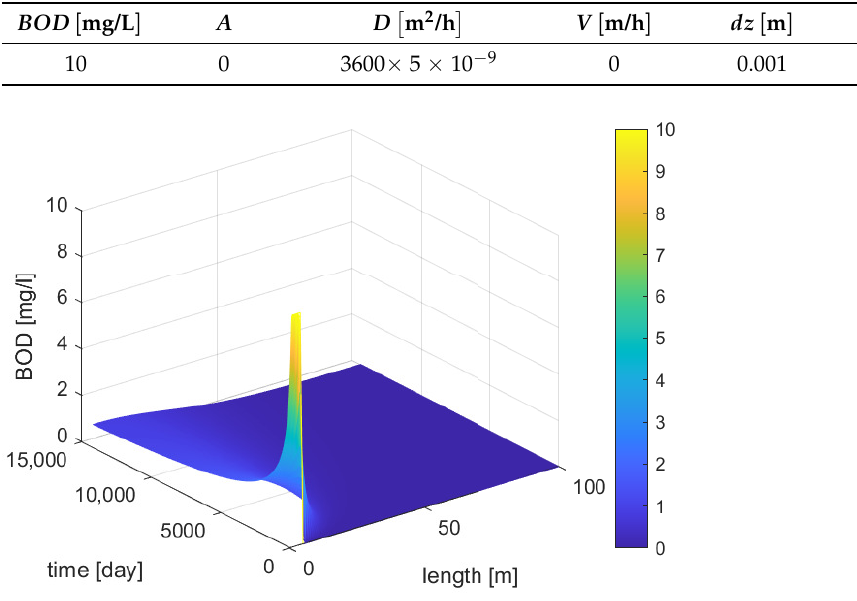
Table 1. Initial values used in the studies.